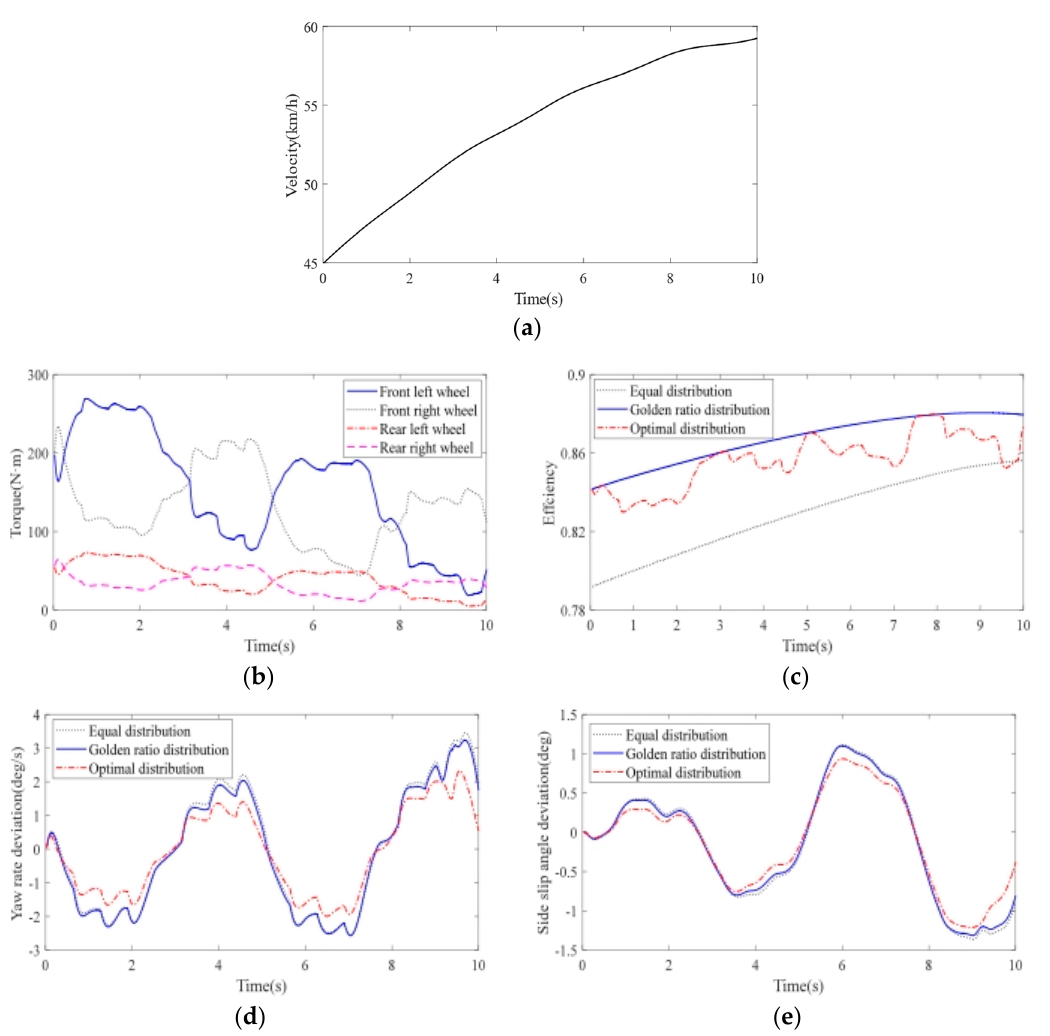
Figure 9. HIL test results of the sine wave steering conditions: ( a ) Vx ; ( b ) optimized motor torque after distribution; ( c ) efficiency; ( d ) yaw rate deviation; ( e ) slip angle deviation.